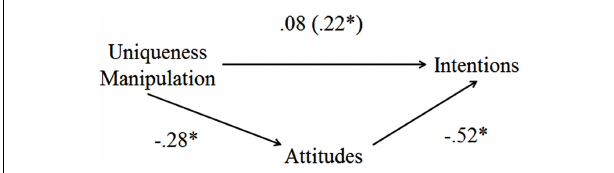
FIGURE 1 | Study 2 mediation model showing the effect of uniqueness on intentions, as mediated through attitudes.